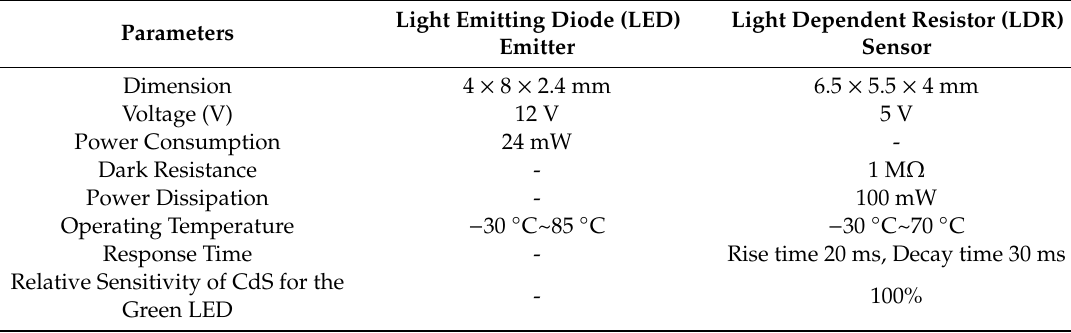
Table 1. Electrical properties of the designed optical sensor